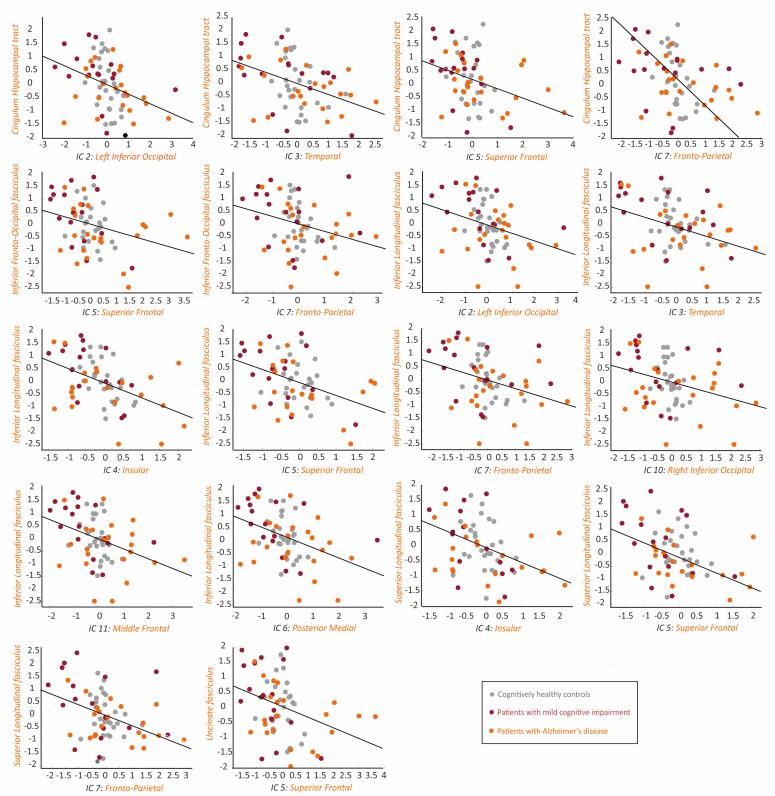
Association between the tau networks and fractional anisotropy of white matter tracts.The plots show significant correlations between the SUVRs of different tau networks and fractional anisotropy values of white matter tracts in 66 amyloid-β positive subjects with both imaging modalities, after regressing out the effects of age, gender and cognitive impairment, and adjusting for multiple comparisons using FDR corrections (q < 0.05). Three outliers were excluded: 2 AD patients and 1 MCI patient.Figure 4—source data 1.Association between the tau networks and fractional anisotropy of white matter tracts.Values for the tau networks and fractional anisotropy of white matter tracts that were significantly correlated with each other, after regressing out the effects of age, sex and presence of cognitive impairment.